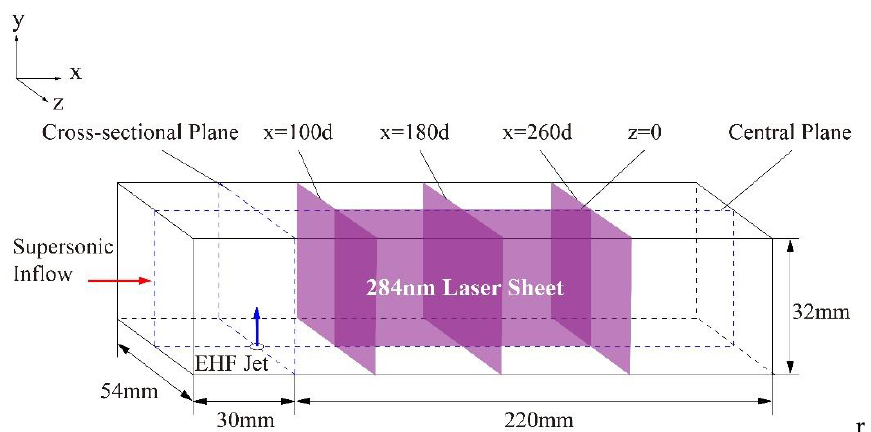
Figure 2. Schematic of test section, injector, and laser optics.